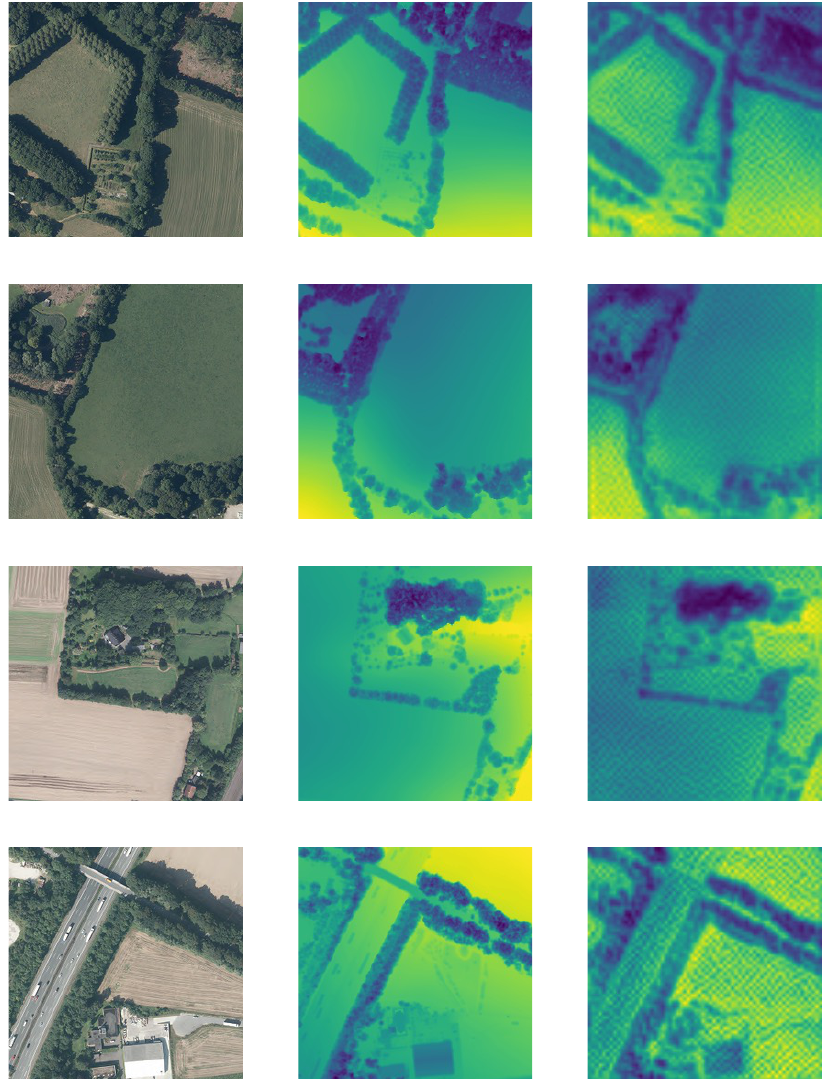
Figure 16. Relative height estimation module generation results. The first column corresponds to the image input to the network, the second column corresponds to the relative height of the actual ground, and the third column represents the relative height of our model.